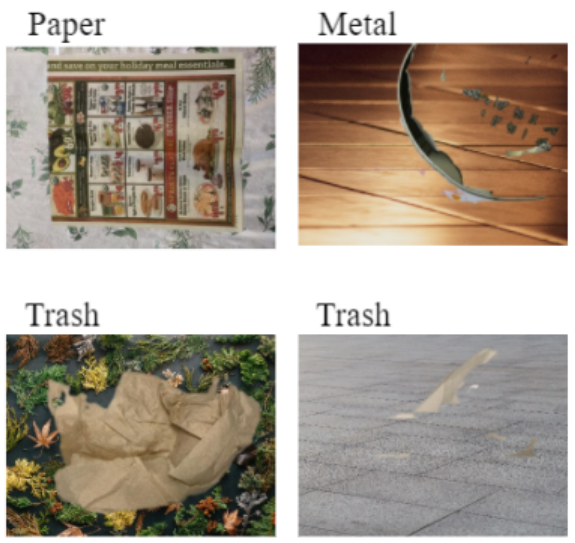
Figure 5. Overlay